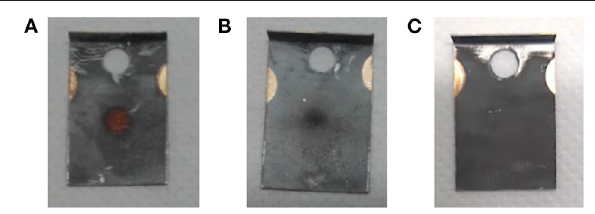
FIGURE 7 | Effect of high ion beam load on the implantation foils. (A) Foil 2B: 919nAh, (B) foil 2A: 208nAh, (C) foil from different radionuclide implantation with < 30nAh ion beam load as